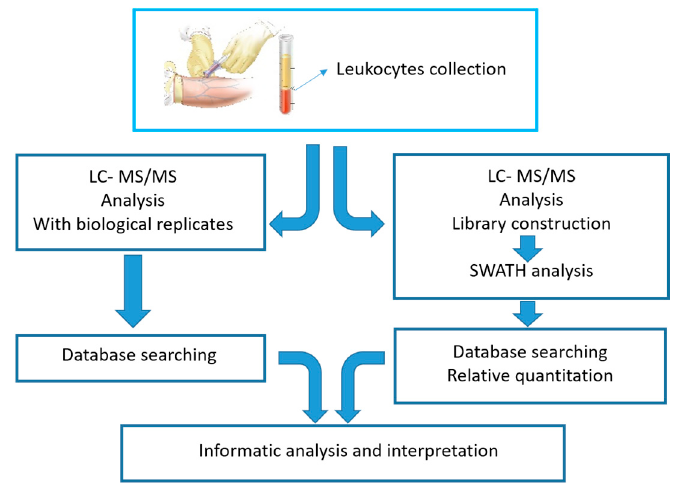
Figure 9. Schematic illustrating the study workflow showing both qualitative (LC-MS/MS, left) and quantitative (SWATH-MS, right) proteomic methods.